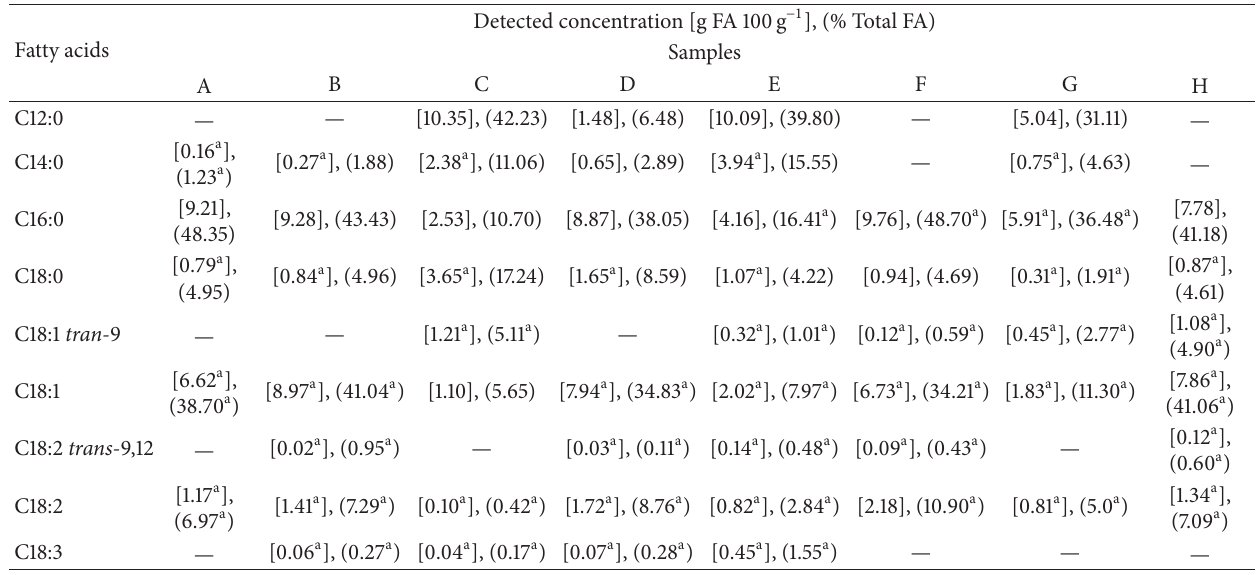
Table 1: The mean of the absolute (g FA 100 g −1 sample) and relative (% of total identified FA) content of each FA determined using the /HCl method. KOCH 3